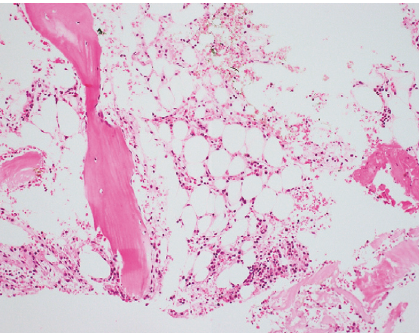
Figure 2: Representative picture of H&E stained bone marrow tissue specimen (original magnification, × 100). His bone marrow showed severe marrow